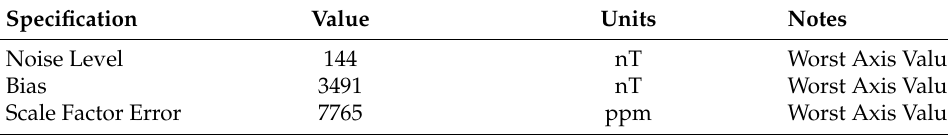
Table 6. Memsense MS3025M magnetometer specifications.